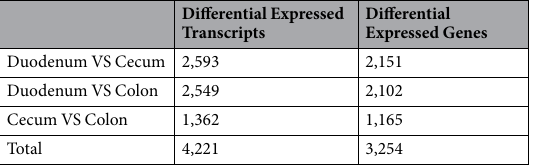
Table 3. The number of differential expressed transcripts and genes identified across the different intestinal region